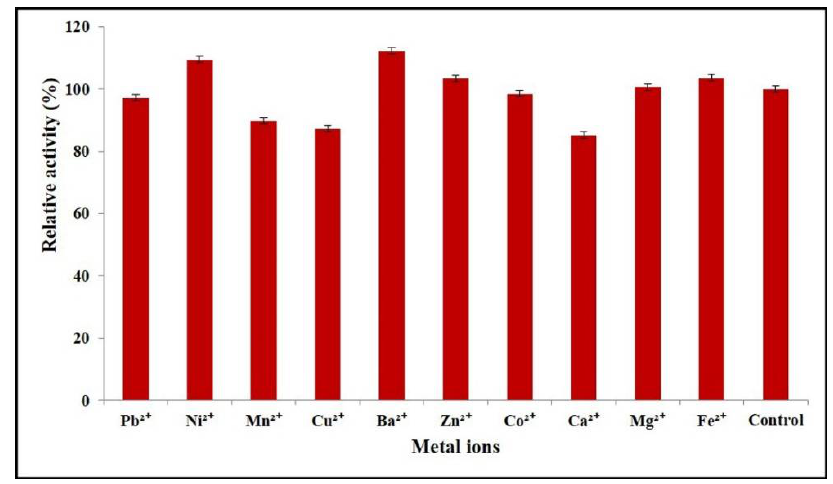
Figure 6. Effects of divalent metal ions on AnEPG activity. Figure 6. E ff ects of divalent metal ions on AnEPG